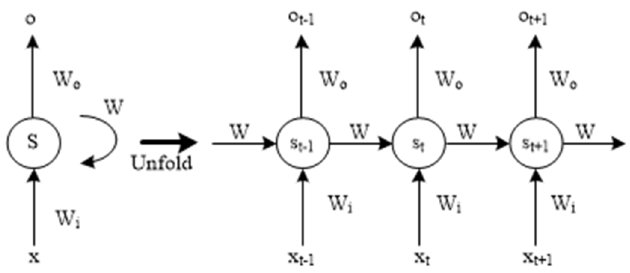
Figure 1. The simplified structure of RNN.